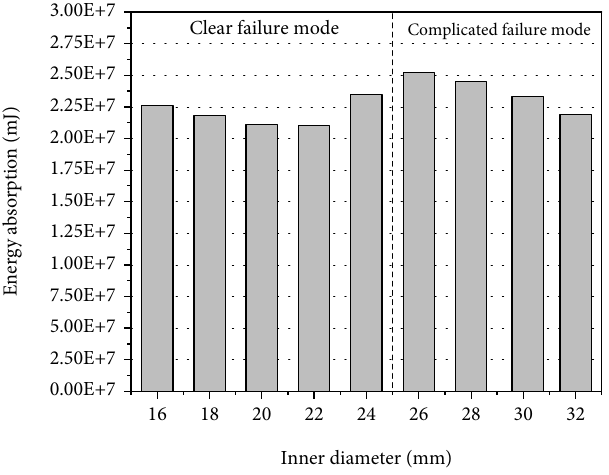
Figure 9: Energy dissipation of the shear pin with di ff erent inner